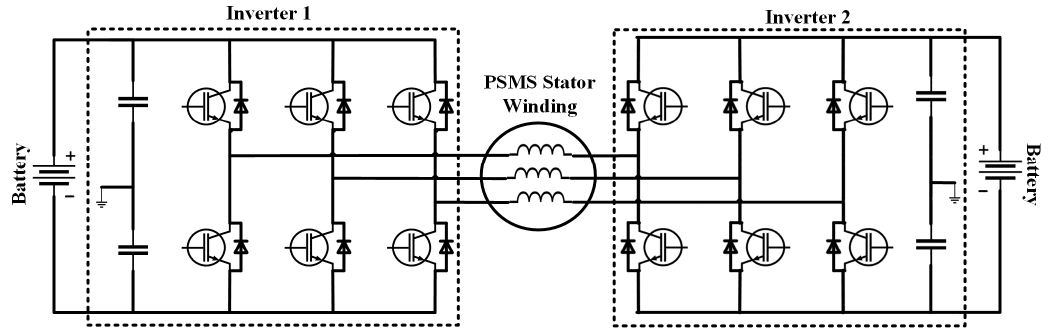
Figure 42. Dual inverter for single source [72].